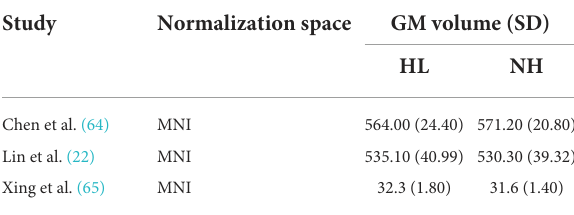
TABLE 5 Available means and standard deviations extracted for meta-analysis of whole-brain